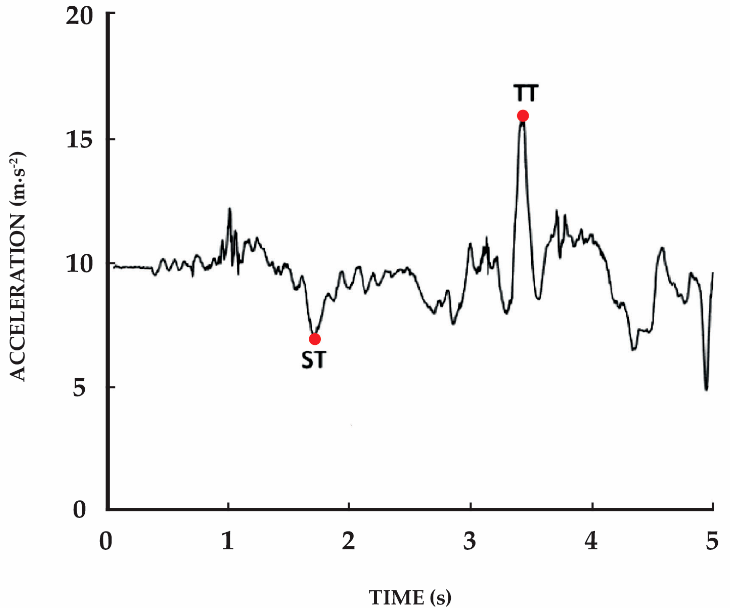
Figure 2. Signal plot of the acceleration during one sit-to-stand repetition (i.e., the complete cycle of stand-up and sit down on the chair); ST: stand-up time; TT: total time.